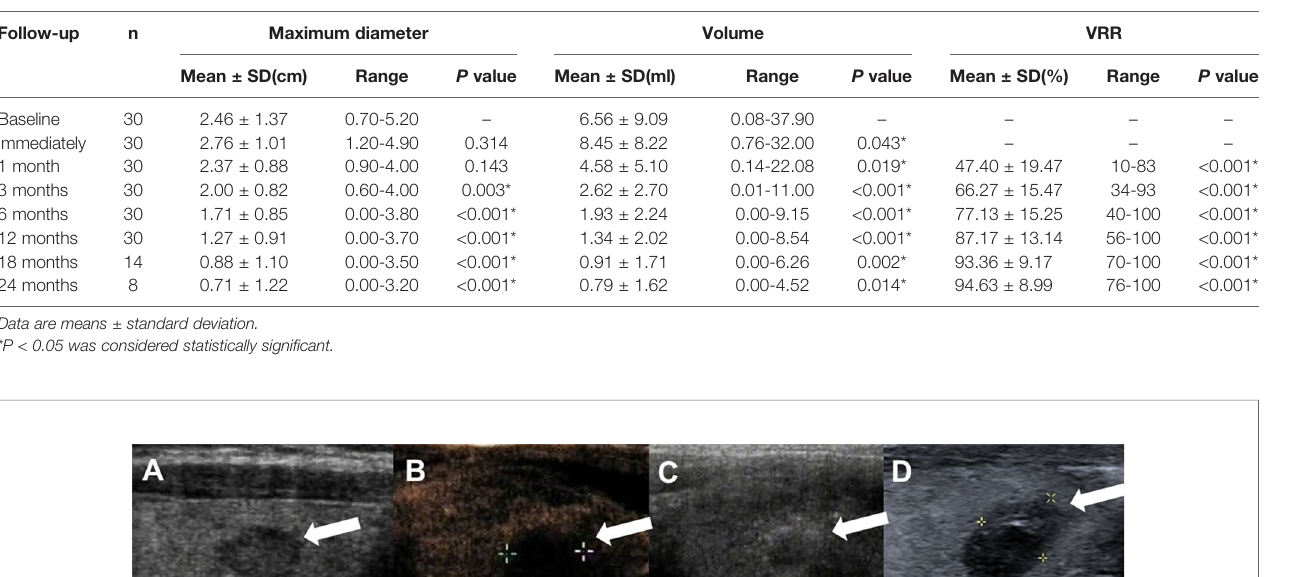
TABLE 2 | Changes of the maximum diameter, mean volume, and reduction rate of the nodule after thermal ablation at each follow-up point.